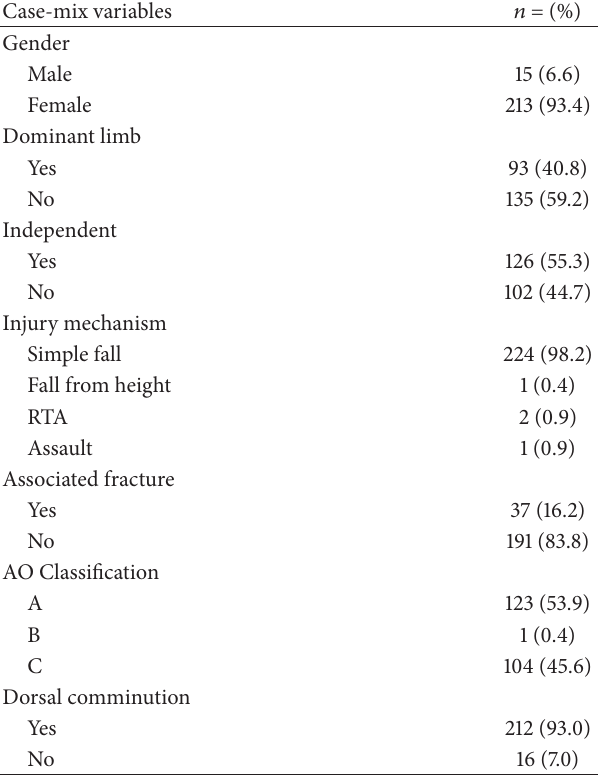
Table 1: Case-mix variables for the study cohort.